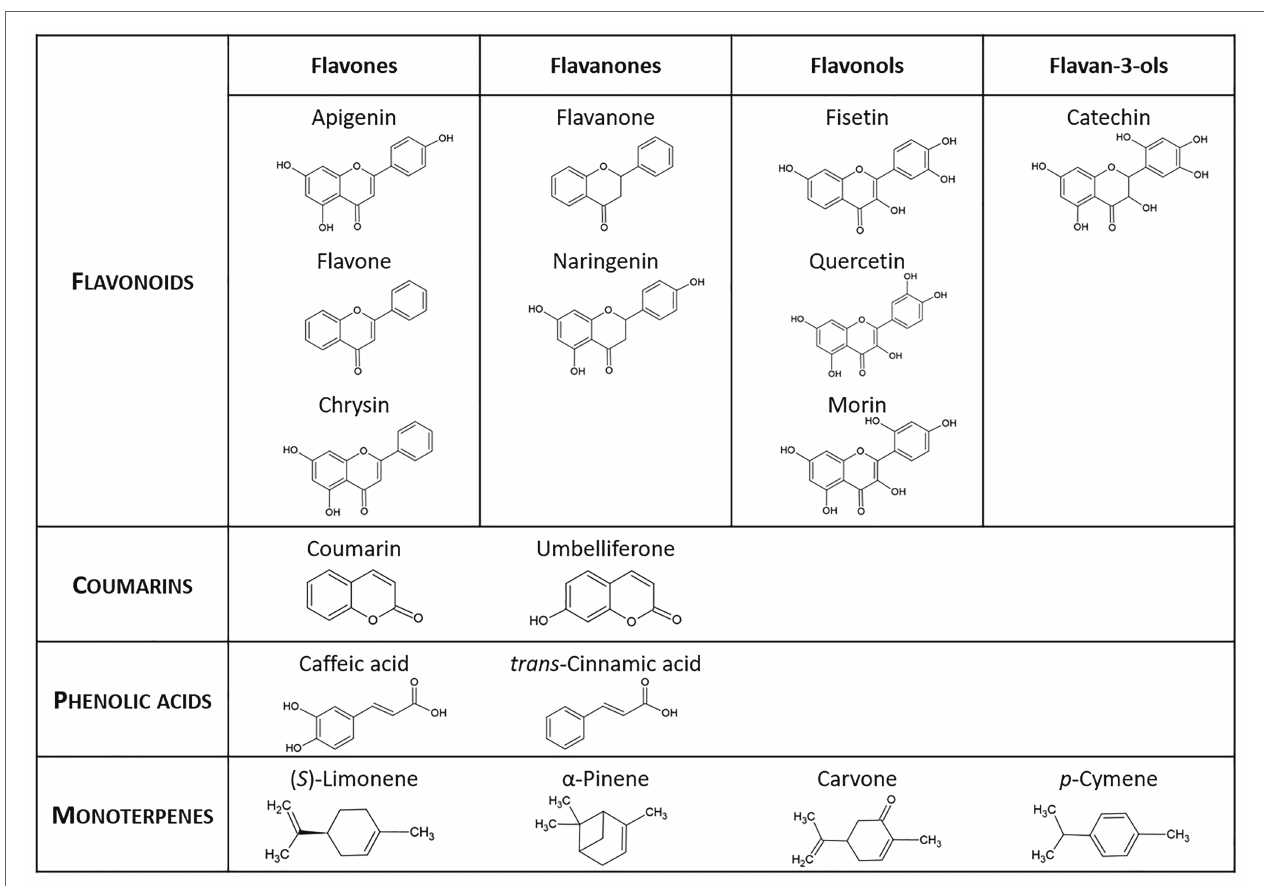
FIGURE 2 | Secondary plant metabolites used in this